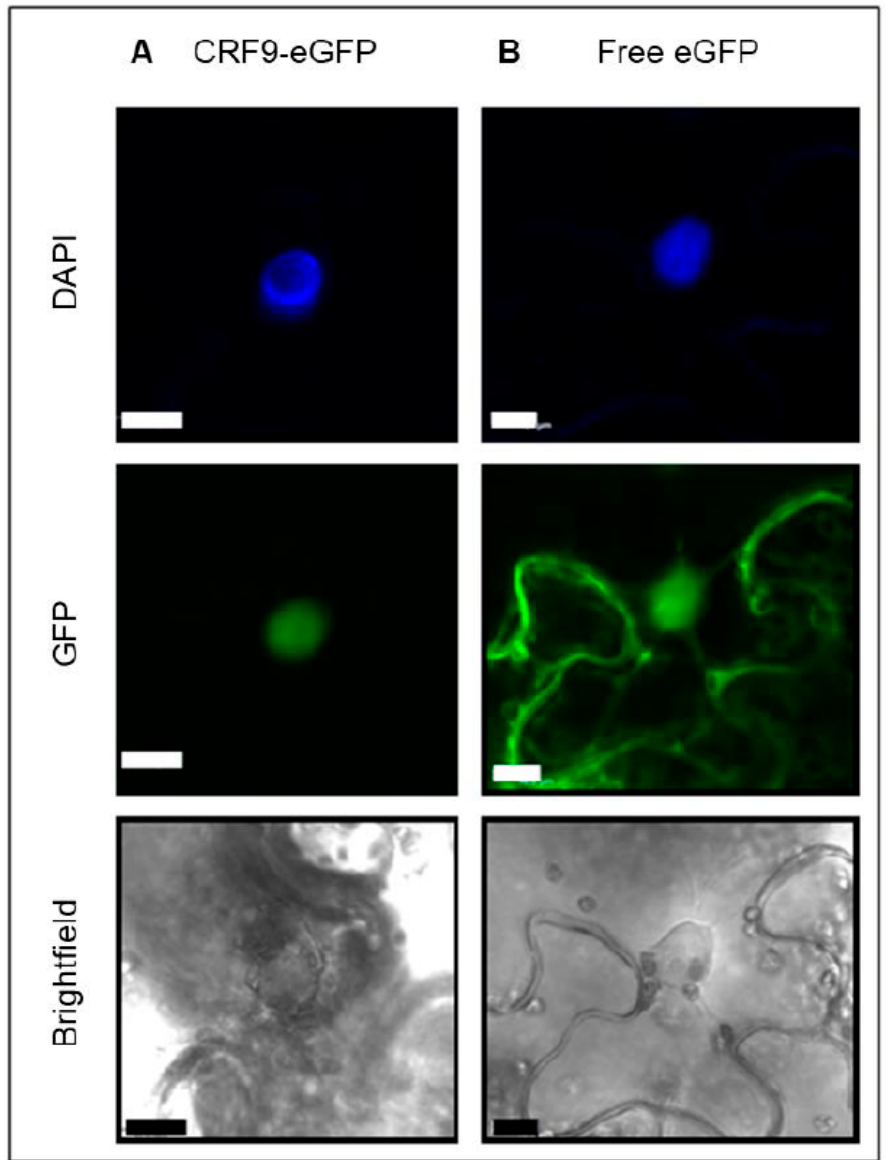
Figure 3. CRF9 is localized in the nucleus. The subcellular localization of CRF9 was determined by fusing the gene to an eGFP moiety and transiently transforming tobacco leaf disk with these constructs. After 48 h, the eGFP fluorescence was determined with a confocal microscope. The eGFP was excited at 488 nm and the emitted radiation was detected between 500–600 nm. The nucleus was stained using DAPI and the signal was detected between 420–490 nm by using a 405 diode in the UV spectrum. Shown is the detected signal of the c-terminal fusion ( A ) CRF9-eGFP and ( B ) free eGFP which served as a negative control. The bar (white or black) represents a size of 10 µm.